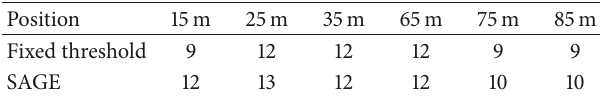
Table 2: Number of multipath components using fixed threshold and